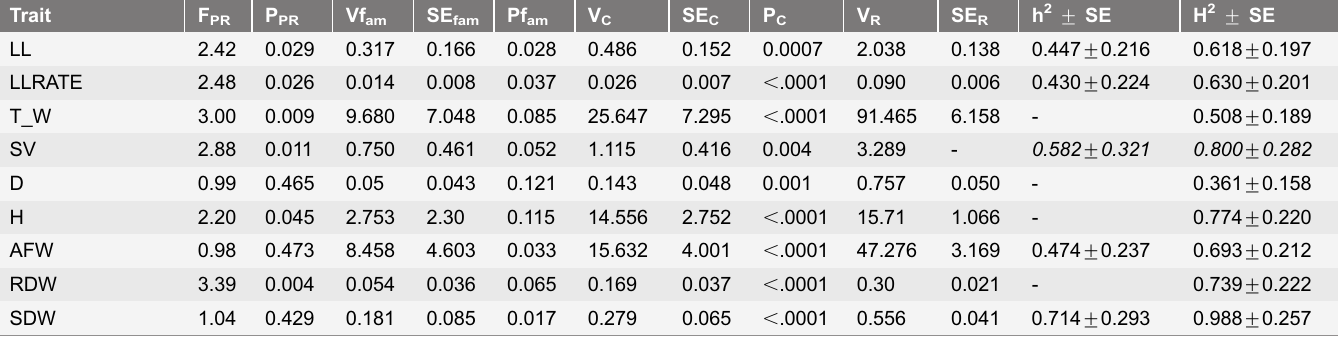
Table 3. Variance components, narrow-sense and broad-sense heritability with their standard error for each trait obtained from the mixed model in the 10 studied populations of P. pinaster (2013 trial). Trait